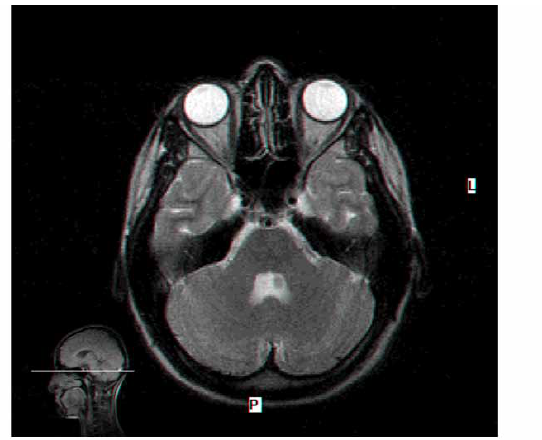
Figure 4. Cranial MRI - 4 years after surgery (normal